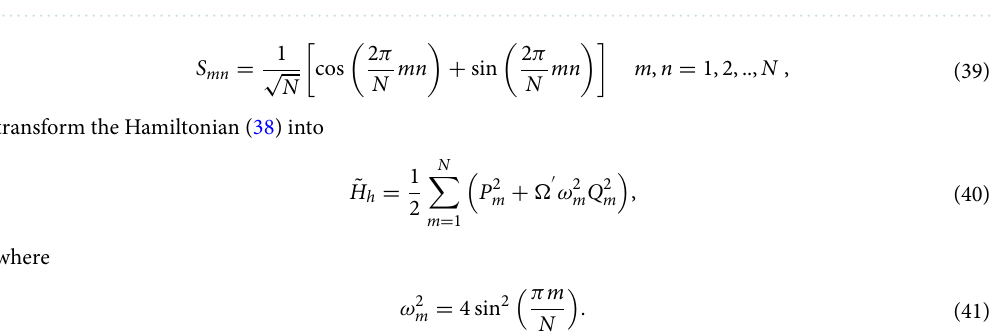
Figure 1. Evolution of the probability amplitude of an electron Initial conditions: T 0.0658 eV, ǫ eV, J = the left one. Time t is measured in 10 −